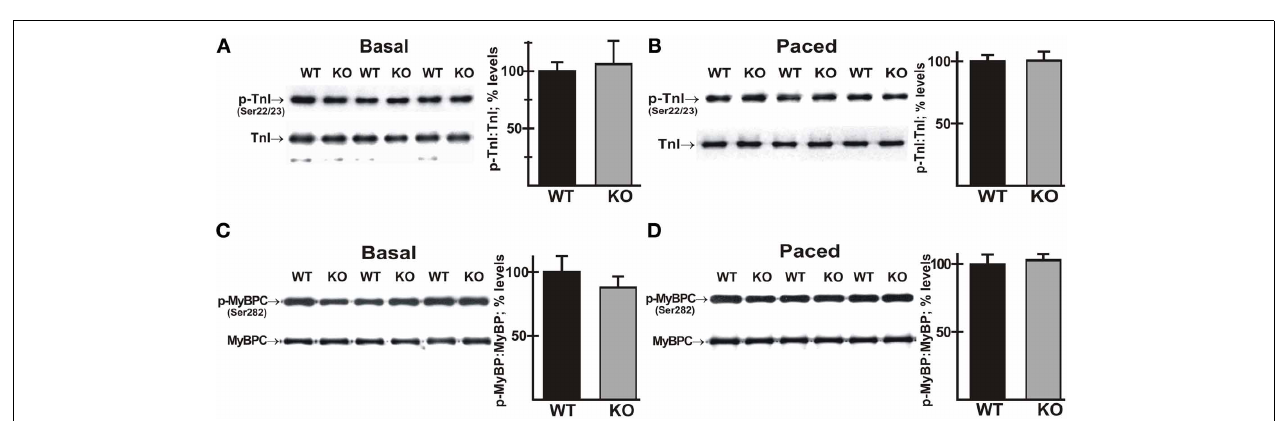
phosphorylated on Thr17 (PT17) and (B) PLN phosphorylated on Ser16 (PS16). Results show representative immunoblot and percent relative levels of phosphorylated PLN (normalized to total PLN levels). Note that PLN phosphorylation did not differ between the two genotypes under basal conditions ( Figures 3G , H ). Values shown are means ± SE, n = 8 for each genotype.